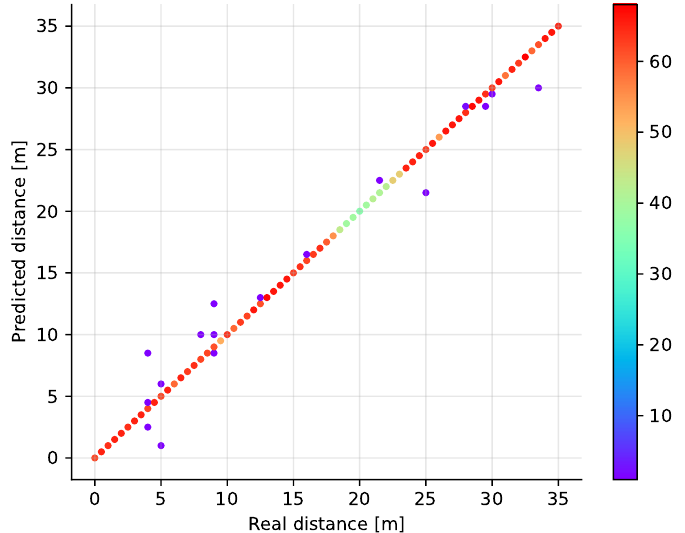
Figure 8. Scatter plot showing the predicted versus the real distances (test set) in a single dimension for the k NN classifier with k =1. The color of the points represents the number of points at a given location.